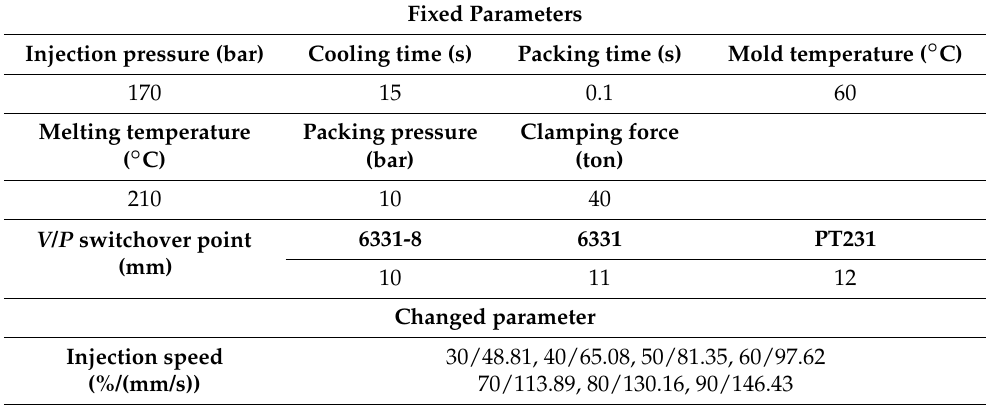
Table 3. Injection speed experiment parameters.